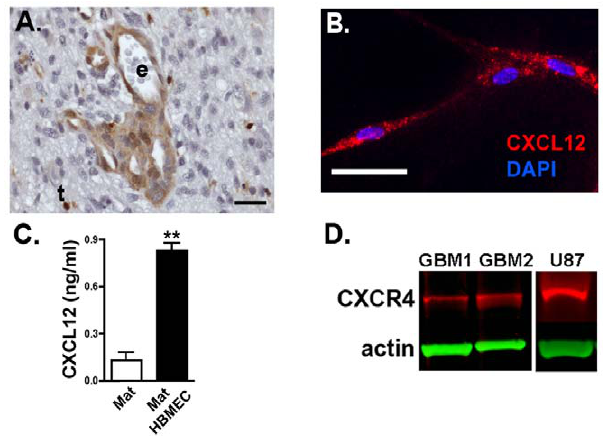
Figure 2. Primary human brain endothelial cells express CXCL12 and GBM cells express CXCR4. ( A ) Human glioblastoma specimen immunostained for CXCL12 (brown) demonstrates expression in vascular endothelial cells. t=tumor cells, e=cross-section through tumor-associated capillary, and Scale bar=25 m m. ( B ) HBMECs, in co- culture on Matrigel, express CXCL12 (red). Nuclei are counterstained blue with DAPI. Scale bar equals 25 m m. ( C ) Human brain micro-vascular endothelial cells cultured on Matrigel (Mat HBMEC) secrete CXCL12 into the media as determined by ELISA. Mat alone indicates results from Matrigel alone-conditioned media. N=3. **=p , 0.005 as determined by two-tailed t -test. ( D ) Single cell suspensions from two different adult GBM patients (GBM1, GBM2) and cultured U87 cells express CXCR4 by western blotting. CXCR4 appears red and the actin loading control appears